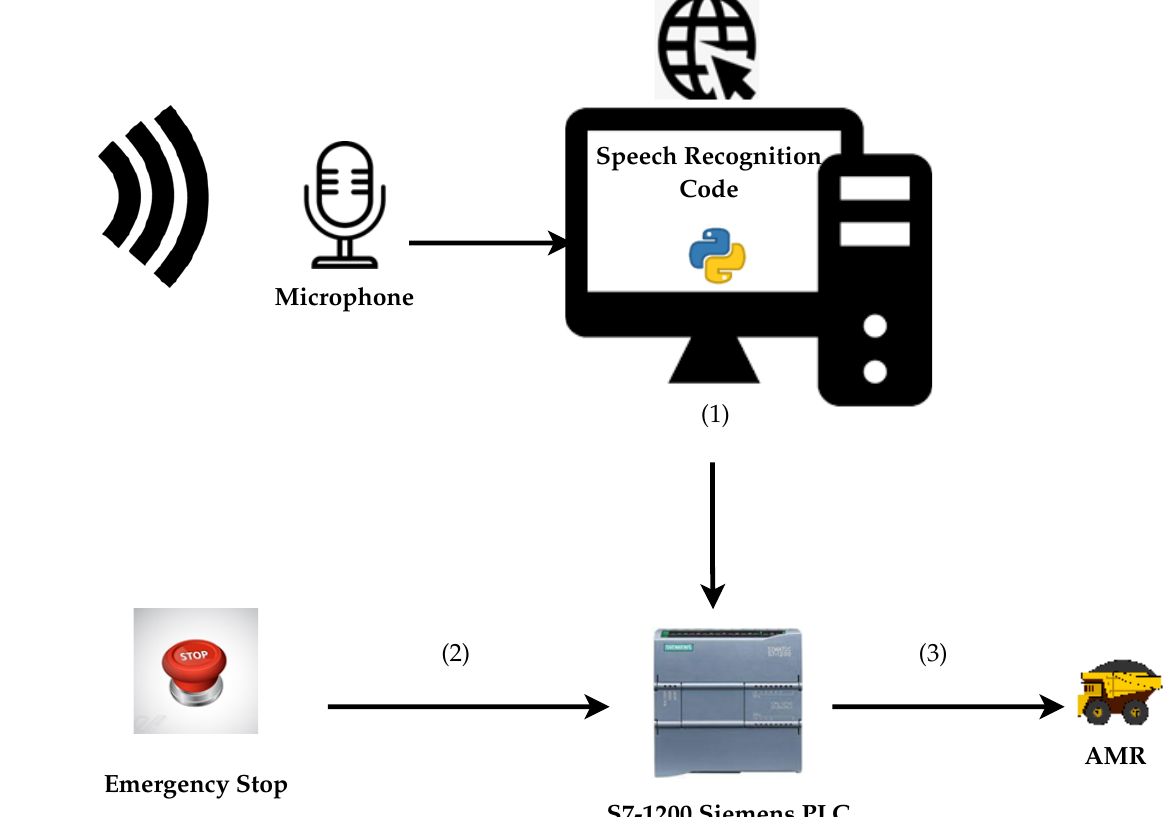
Figure 2. From voice command to PLC emergency evacuation signal